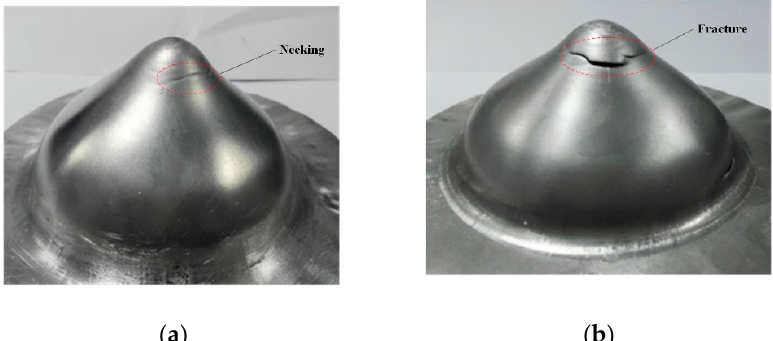
Figure 3. The high-speed electromagnetic forming with ( a ) necking; and ( b ) fractured specimens.